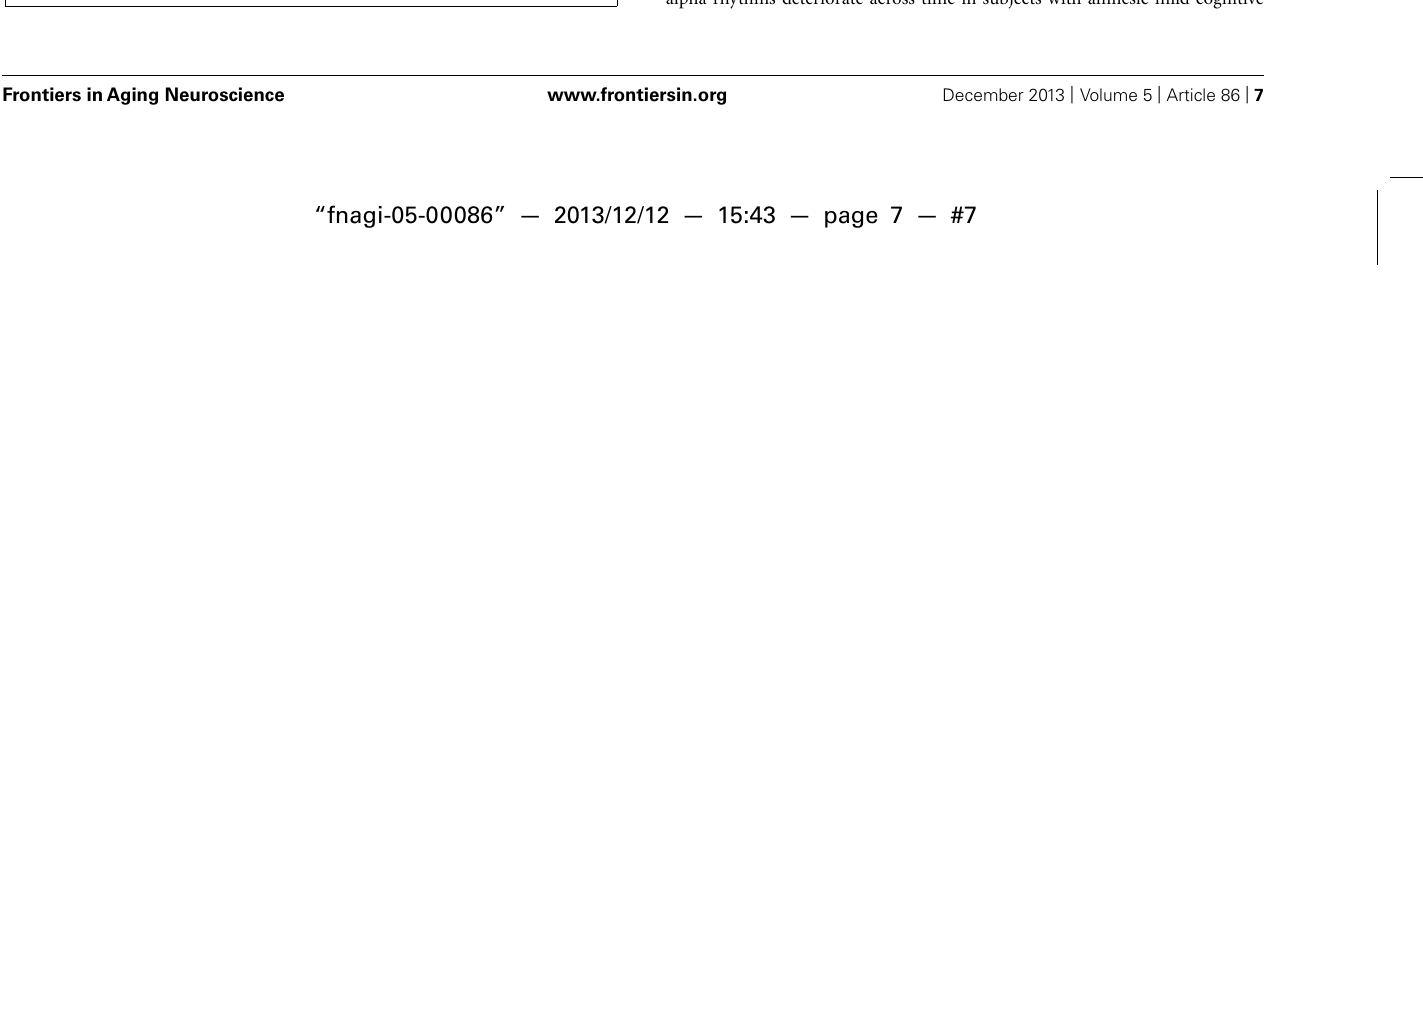
FIGURE 4 |Topographic distribution of alpha1 (A), alpha2 (B), and alpha3 (C) absolute power (mean and SE) in young and old carriers of CLU CC and CLU CT & TT genotypes in occipital O, frontal F, frontal poles Fp, temporal posteriorTp, and temporalT areas. Triangle indicates significant differences between the CLU CC and CLU CT & TT carriers P < 0.05